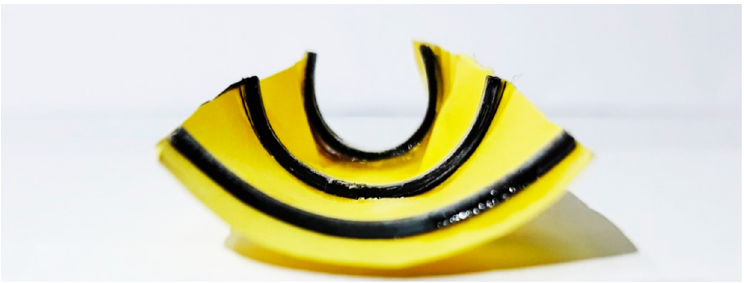
Figure 9. Configuration of the flat sheet reinforced by three straight 4D-printed beams after the heating–cooling process.